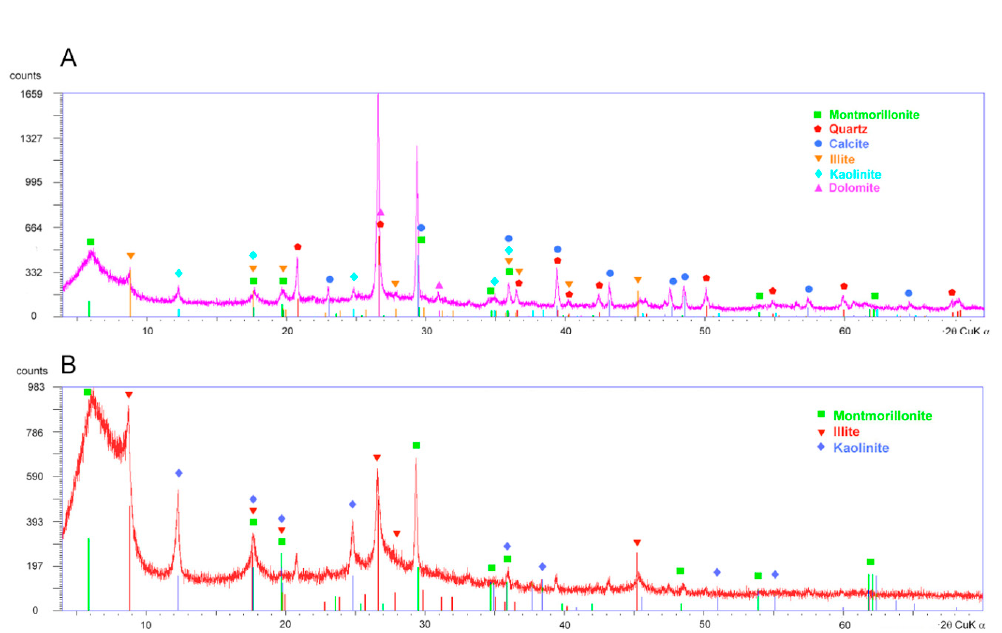
Figure 5. X-ray diffraction patterns of ( A ) powder samples and ( B ) oriented samples (<2 µm fraction) Figure 5. X-ray di ff raction patterns of ( A ) powder samples and ( B ) oriented samples ( < 2 µ m fraction) from the clay-rich layer of the Diezma landslide. from the clay-rich layer of the Diezma